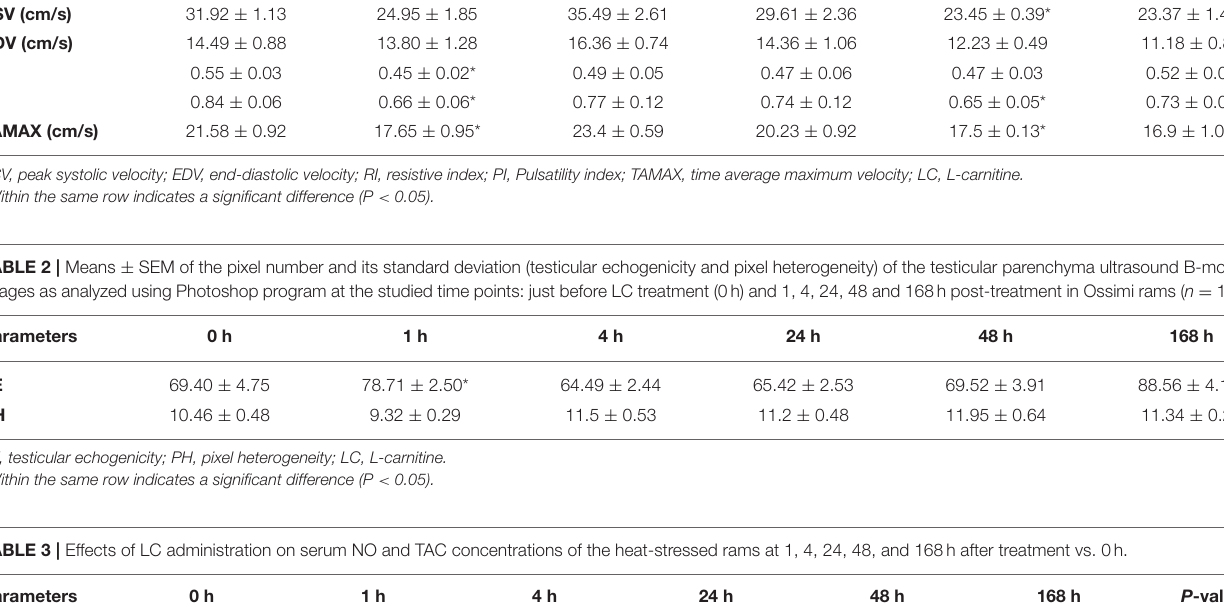
TABLE 1 | Means ± SEM of the Doppler ultrasound measures of the supra-testicular arteries at the studied time points: just before LC treatment (0h) and 1, 4, 24, 48, and 168h post-treatment in Ossimi rams ( n = 15). Parameters